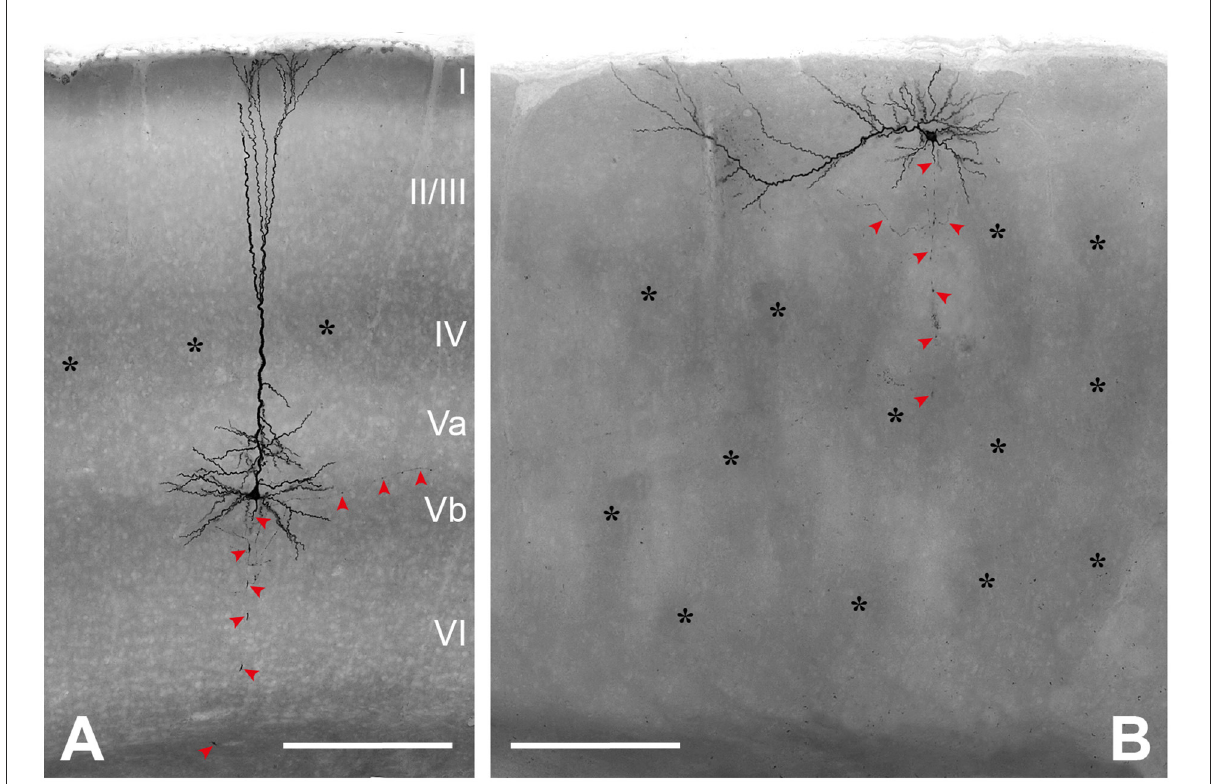
FIGURE2 Morphological characterization of (LVb) repetitively burst-spiking (RB) pyramidal cells. (A) Representative example of an RB pyramidal cell in LVb of WT. (B) Representative example of an RB pyramidal cell close to the pial surface and on top of barrel equivalents in reeler. Both images represent minimum intensity projections of all-optical planes containing biocytin-labeled profiles, which mask details of the axonal arbor (red arrowheads). Asterisks mark barrels (A) or barrel equivalents (B) see also Wagener et al. (2016). Scale bars: 250 µ m.